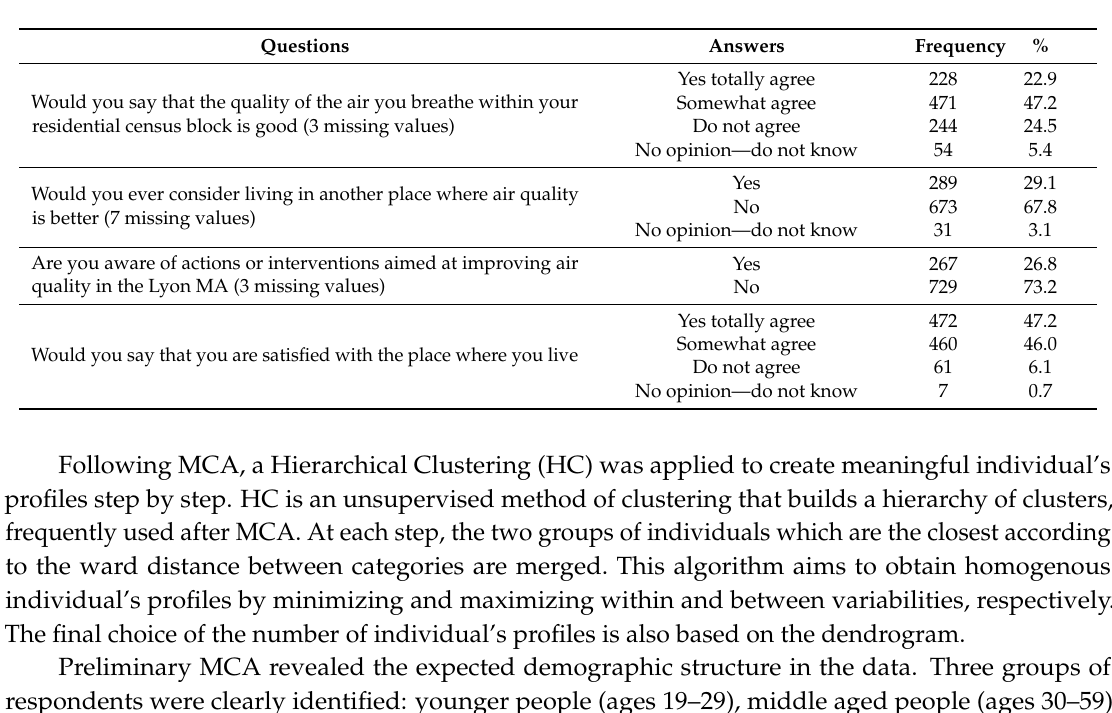
Table 2. Descriptive statistics of variables dealing with perception and